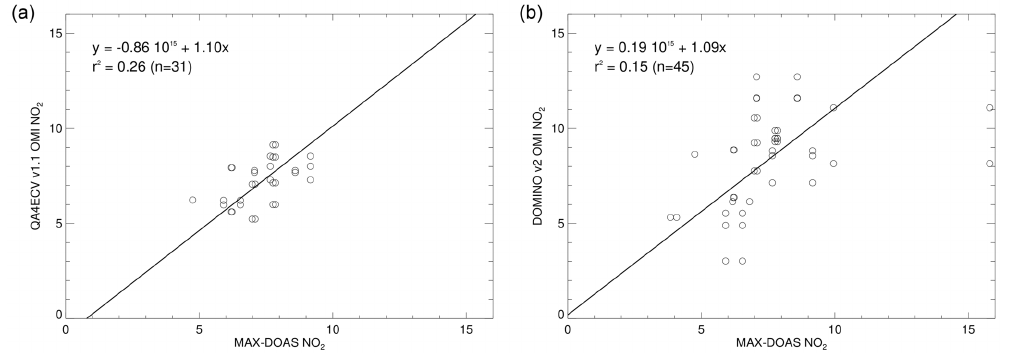
Figure 12. (a) Scatter plot of QA4ECV OMI vs. MAX-DOAS tropospheric NO 2 columns for Tai’an (China) in May–June 2006. The solid line shows the result of a reduced major axis regression to the data. Only pixels measured a cloud radiance fraction <0.5 and an effective cloud pressure <875hPa, within 20km and 30min of a MAX-DOAS measurement have been selected. (b) Same as (a) , but now for DOMINO v2 vs. MAX-DOAS tropospheric NO 2